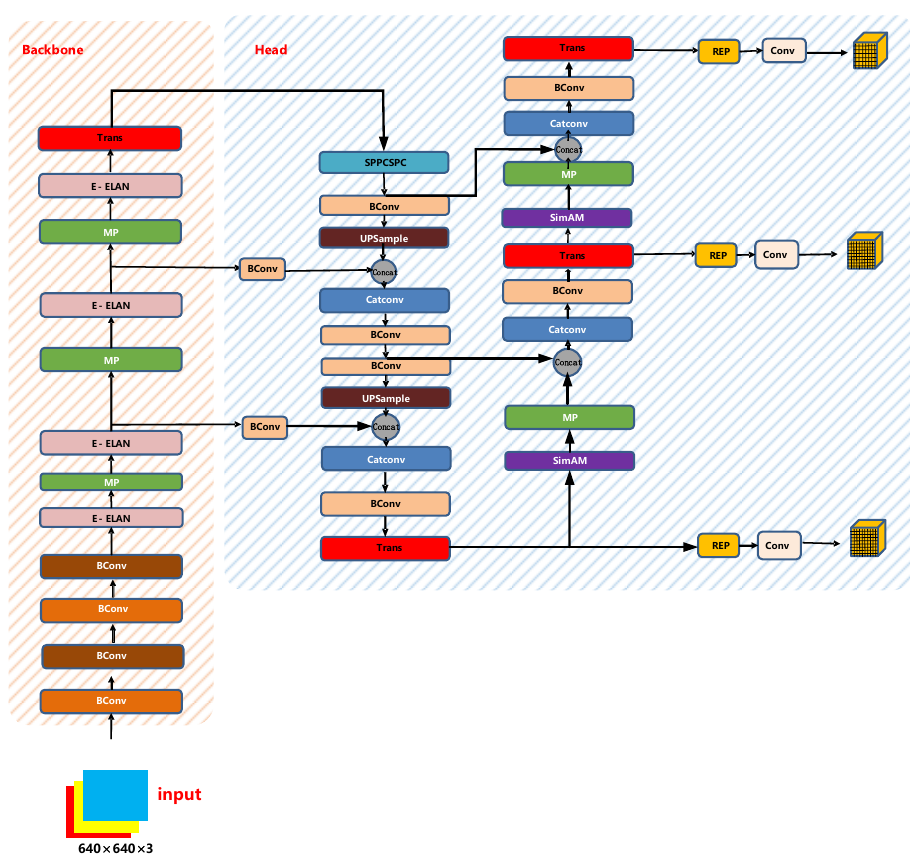
Figure 19. YOLO-SAMT network structure diagram.